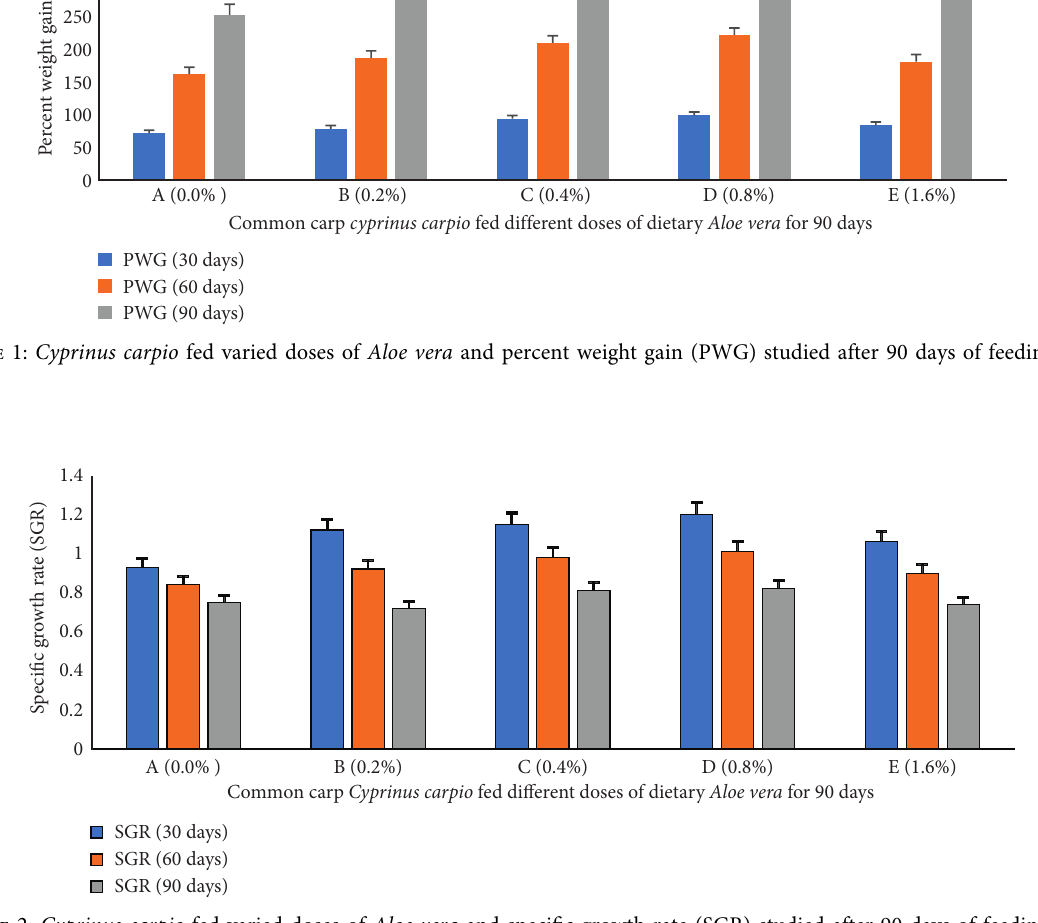
Figure 2: Cyprinus carpio fed varied doses of Aloe vera and specific growth rate (SGR) studied after 90 days of feeding trial.